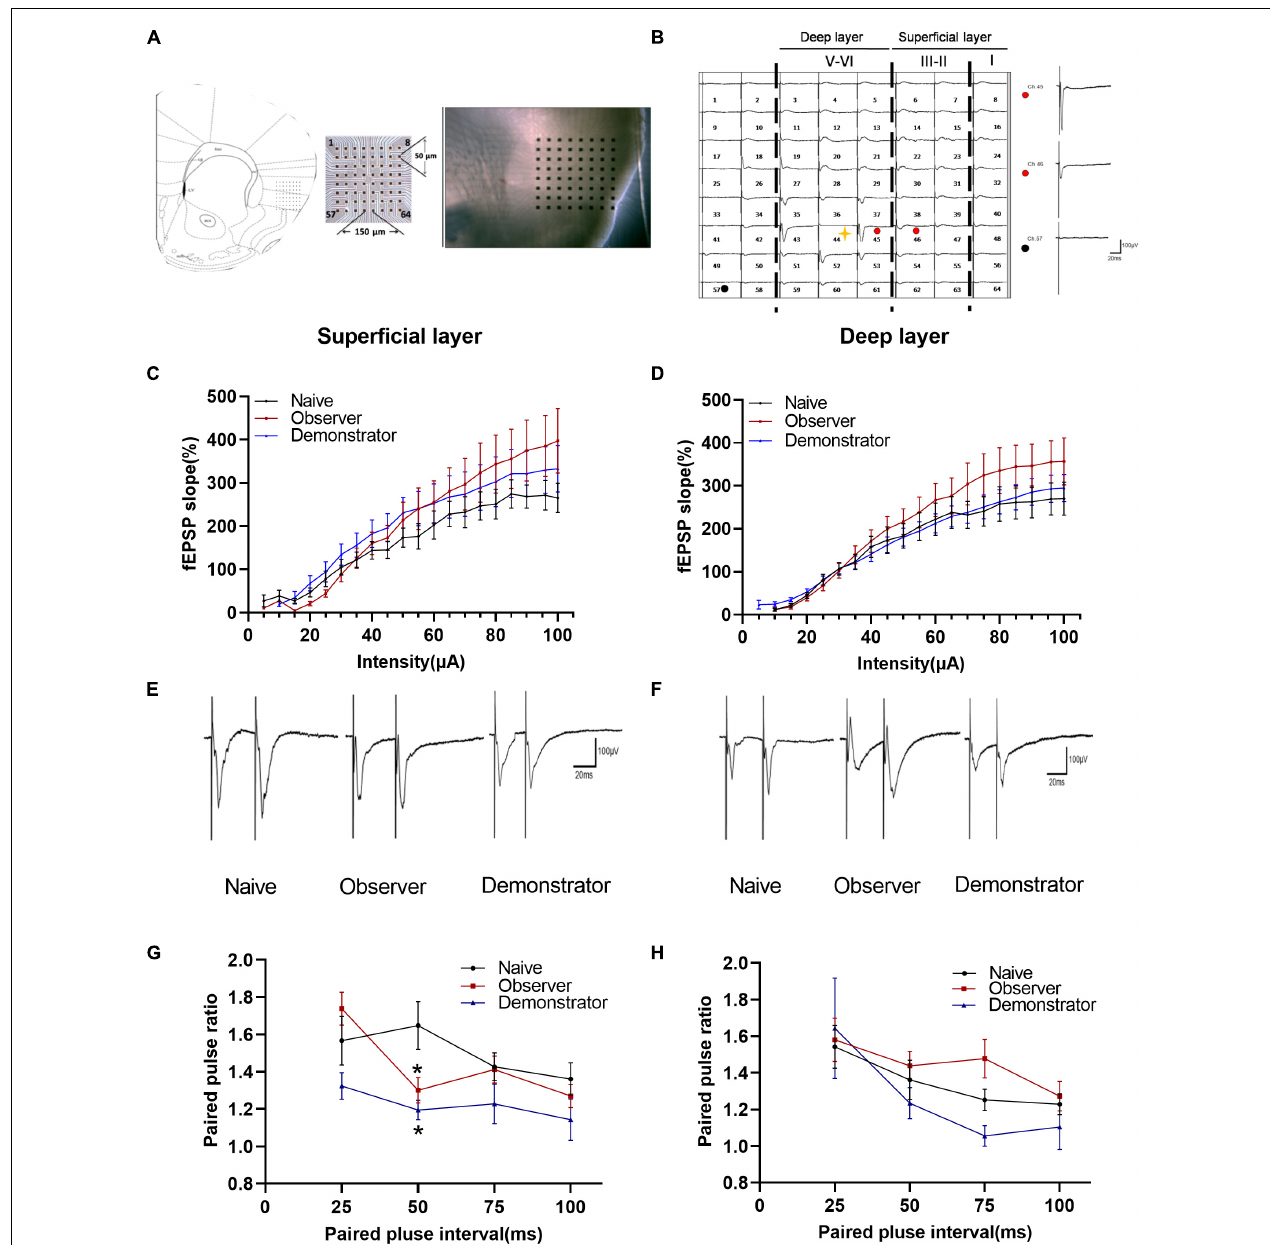
FIGURE 2 | Changed presynaptic transmitter release probably within aIC of observer and demonstrator mice. (A) Left: schematic diagram showing location of the MED64 probe on the coronal IC slice; Right: light microscopy photograph showing relative location of aIC within the probe; (B) Spatial distribution of extracellular field potential induced by electrical stimulation on channel 45 (marked as red circle) in layers VI of aIC; (C,D) Input–output curve of fEPSP slope (%) vs. stimulus intensity (mA) in the slice among naïve ( n = 4 slices of 3 mice), observer ( n = 4 slices of 3 mice), and demonstrator ( n = 7 slices of 5 mice) in the superficial (C) and in the deep layers (D) of aIC; (E,F) Example traces of paired-pulse facilitation (PPF) with an interval of 25 ms recorded in the superficial (E) and deep layers (F) of aIC; (G,H) The paired-pulse ratios (slope of fEPSP2/slope of fEPSP1) recorded with intervals of 25, 50, 75, and 100 ms in superficial (G) and deep layers (H) of aIC; Data are shown as mean ± SEM (PPF: Naïve n = 4 slices of 3 mice, observer n = 7 slices of 6 mice, and demonstrator n = 4 slices of 4 mice) and compared by two-way ANOVA analysis followed by Tukey’s multiple comparisons test, * p < 0.05, vs. naïve.